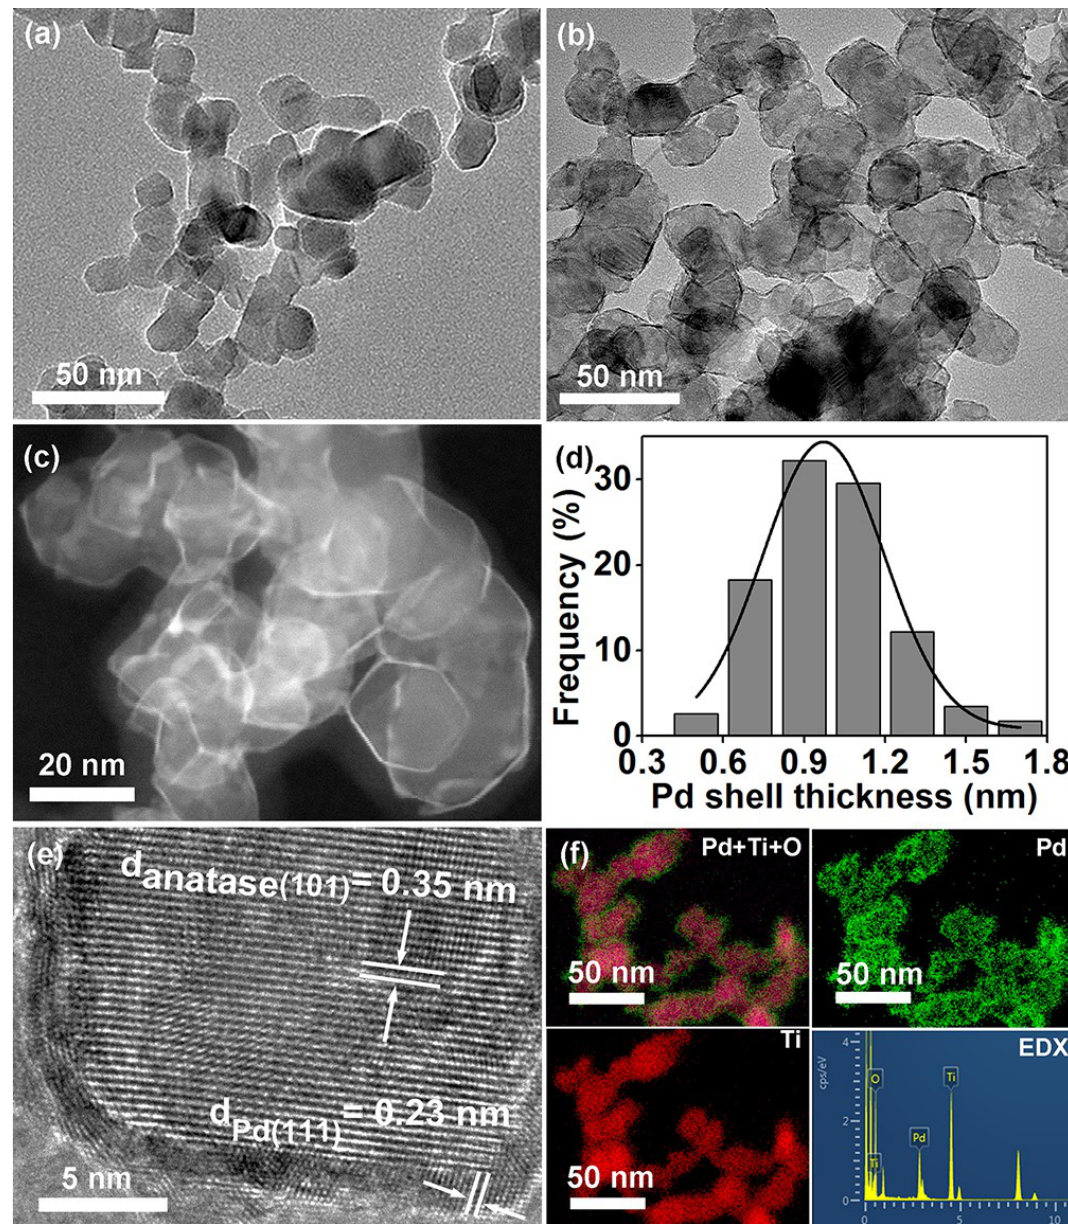
Figure 1. Transmission electron microscopy (TEM) images of ( a ) P25 support and ( b ) P25@Pd core-shell catalyst; ( c ) high angle annular dark field scanning (HAADF-STEM) image, ( d ) Pd shell thickness distribution, ( e ) high resolution TEM (HRTEM) image, and ( f ) elemental mapping results of P25@Pd core-shell catalyst.